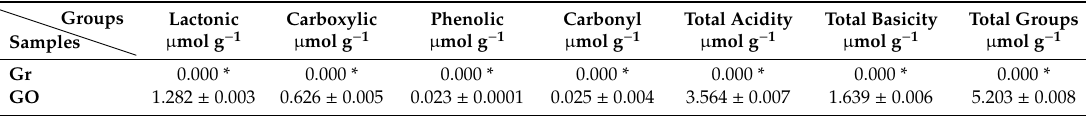
Table 4. Superficial groups ( µ mol g − 1 ) for Gr and GO determined by the Boehm method. Samples